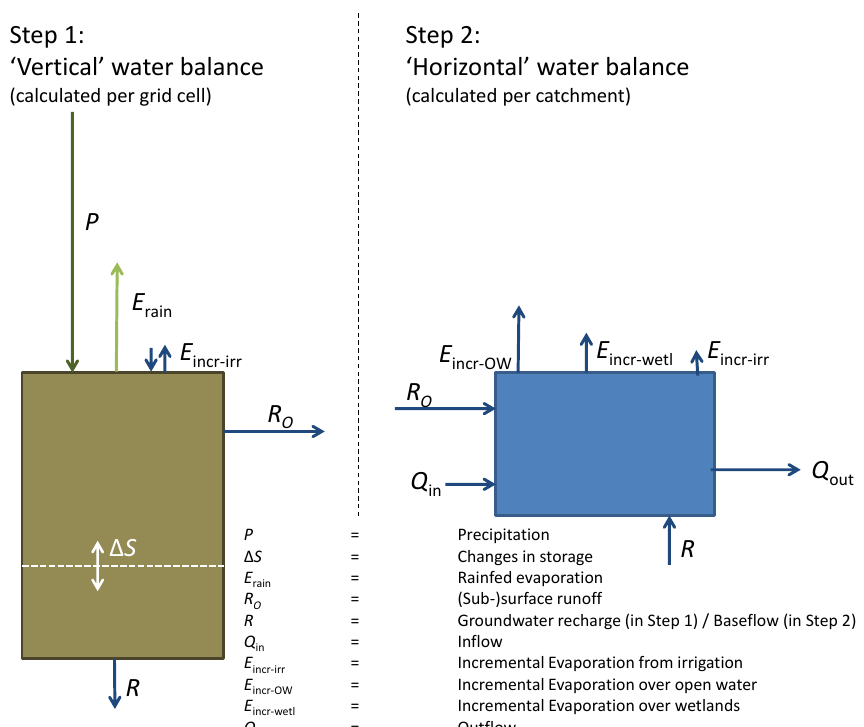
Figure 1. Schematic representation of modelling steps.